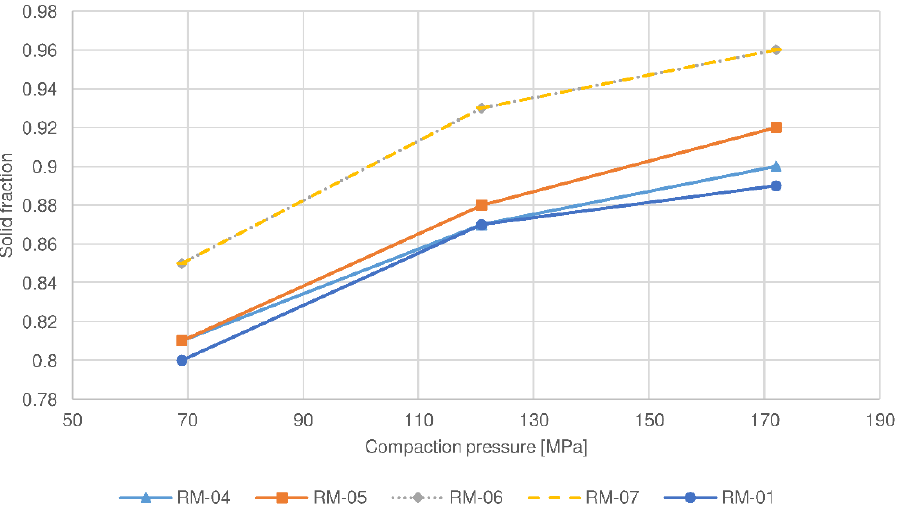
Figure 5. Compressibility plot of selected compression mixtures containing microcrystalline cellulose (MCC) as a filler.